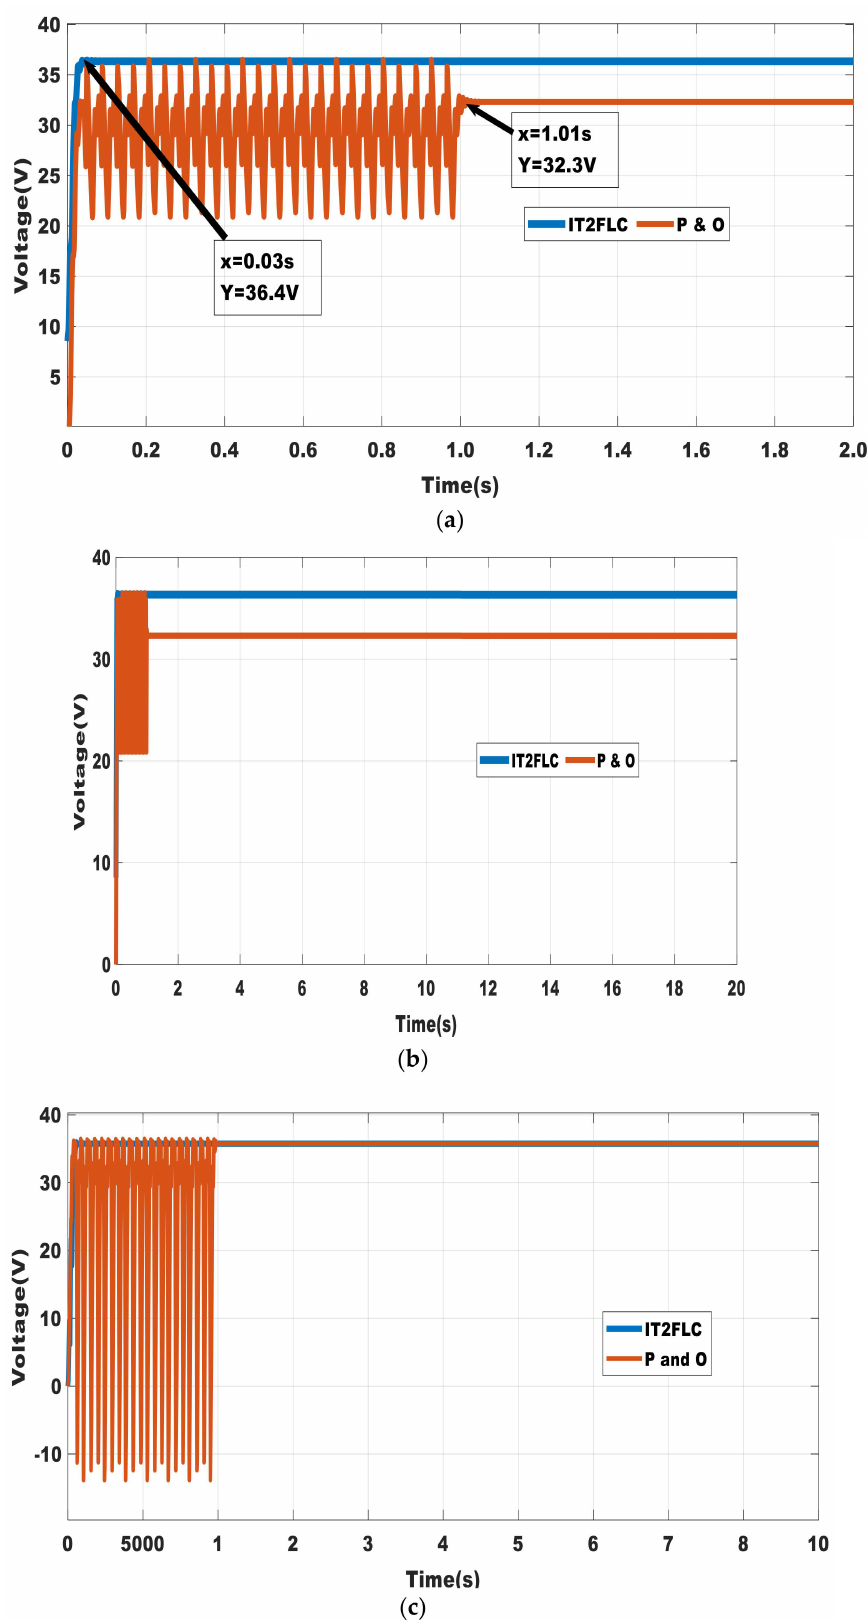
Figure 16. ( a ) Voltage response for a fixed input at longer time; ( b ) Voltage response for a fixed input at longer time; ( c ) Voltage response for a fixed input at